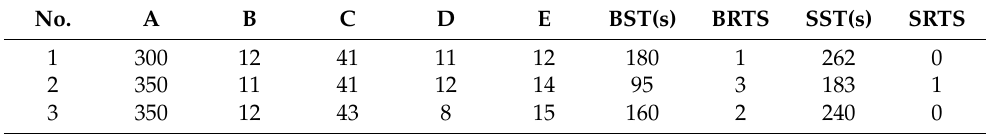
Table 8. Stable process time and wire rupture times of both BWE and